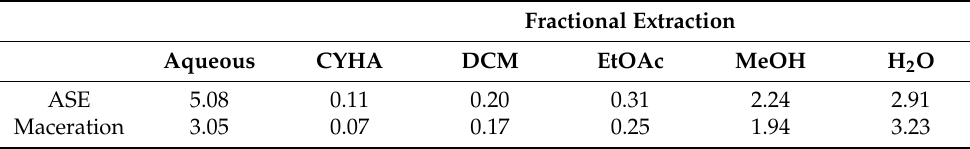
Table 1. Extraction yields of V. vinifera stem extracts (DW %) extracts (CYHA: cyclohexane,